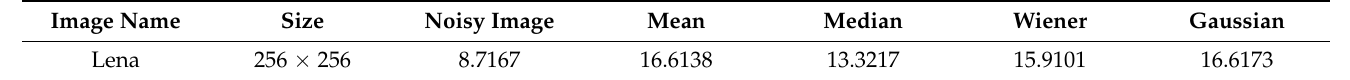
Table 1. Lena image under four classical filtering algorithms for PSNR (dB).